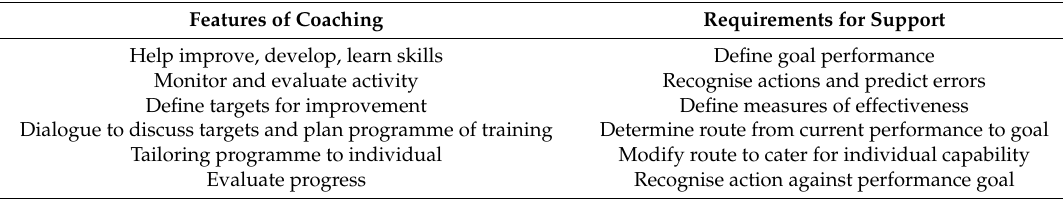
Table 1. Support for coaching.